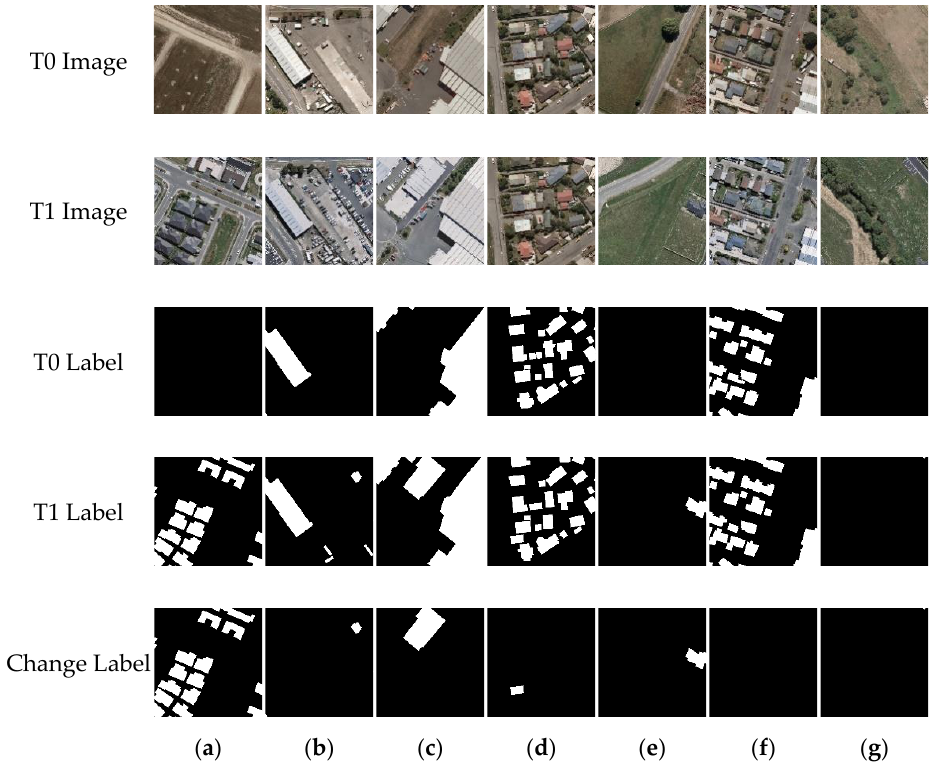
Figure 4. The images of 512 × 512 pixels are obtained by cropping the BCDD dataset. Each column represents a group of samples, containing five images of prechange, postchange, and ground truth. In T0 and T1 labels, white and black represent buildings and background, respectively. In change labels, white and black represent changed and unchanged areas, respectively. Panels ( a – e ) show changes in buildings, whereas ( f , g ) show no change.